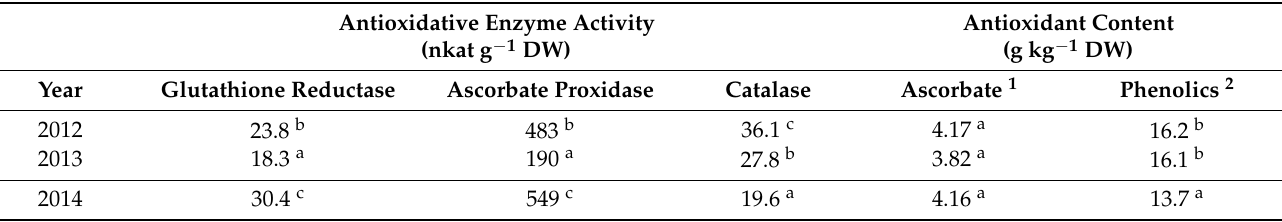
Table 1. Growing season effect on apple peel component